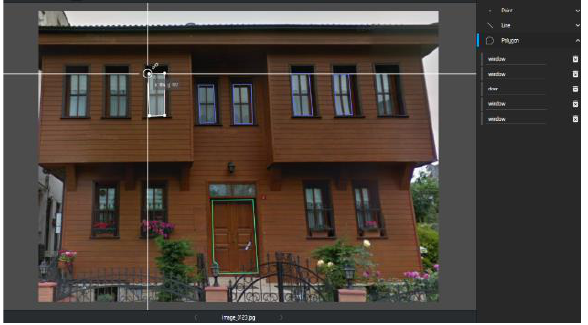
Figure 1 . A sample of data labeling.